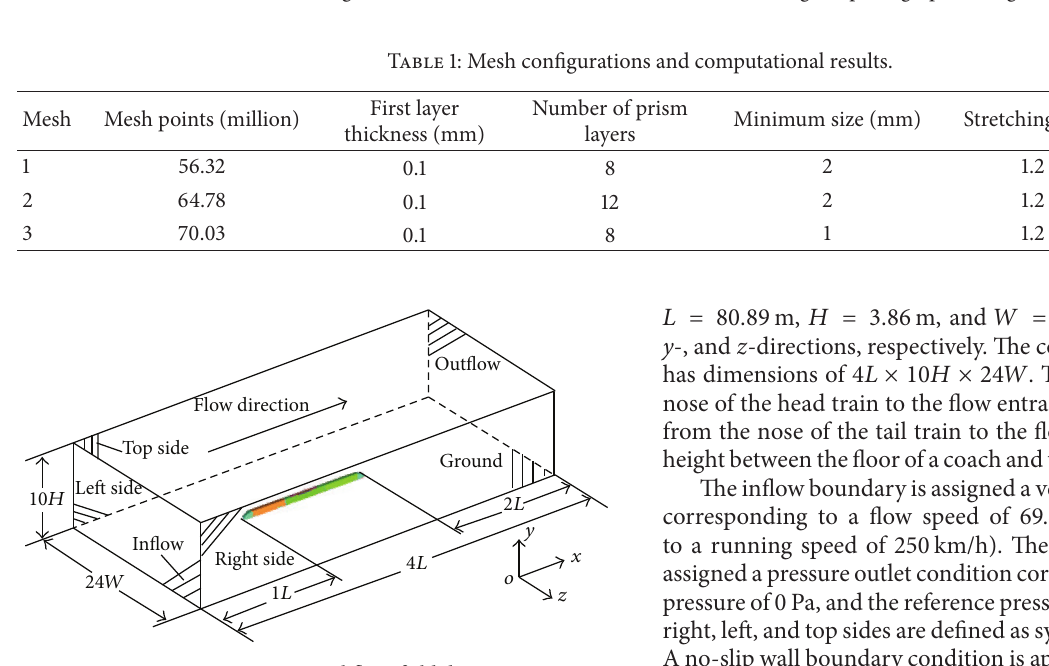
Figure 2: Computational flow-field